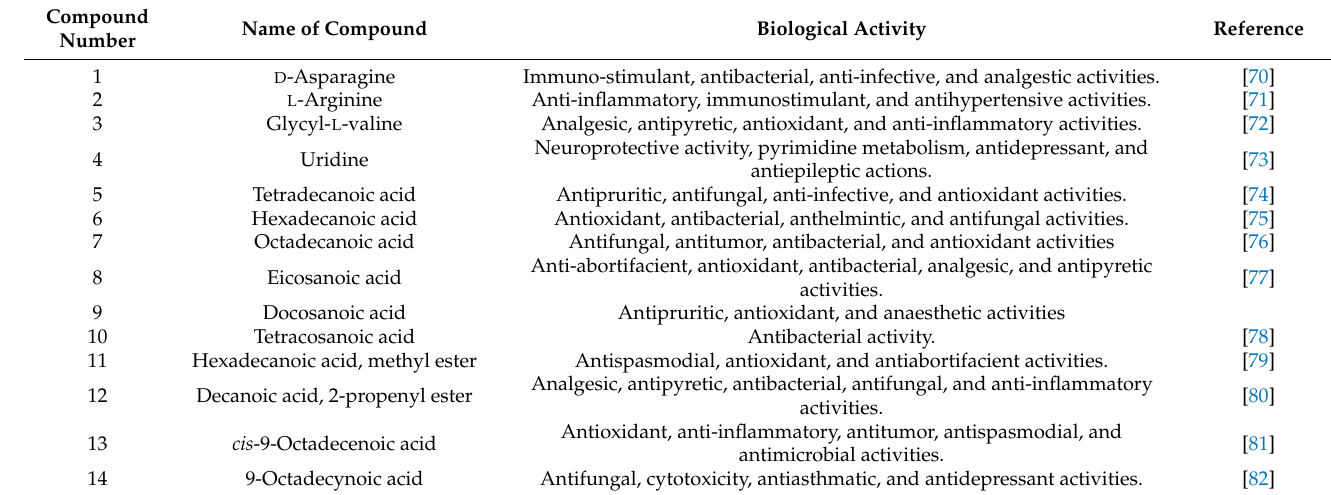
Table 4. Compounds identified in R. tomentosa rhizomes and their biological